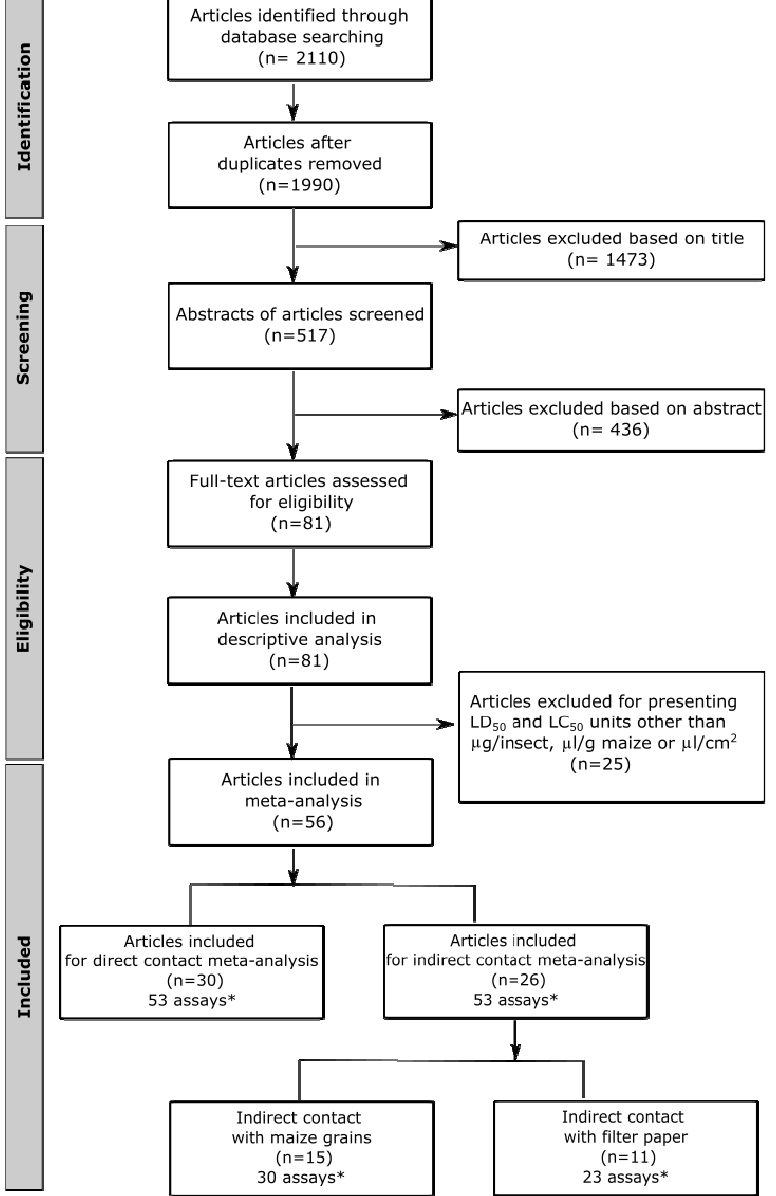
Figure 1. PRISMA flowchart of systematic review and meta-analyses of the excluded and included studies. The flow diagram shows the search results and selection procedure. *Each study used for the meta-analysis was defined for a given plant essential oil (EO) / exposure time /LC50 or LD50 combination.